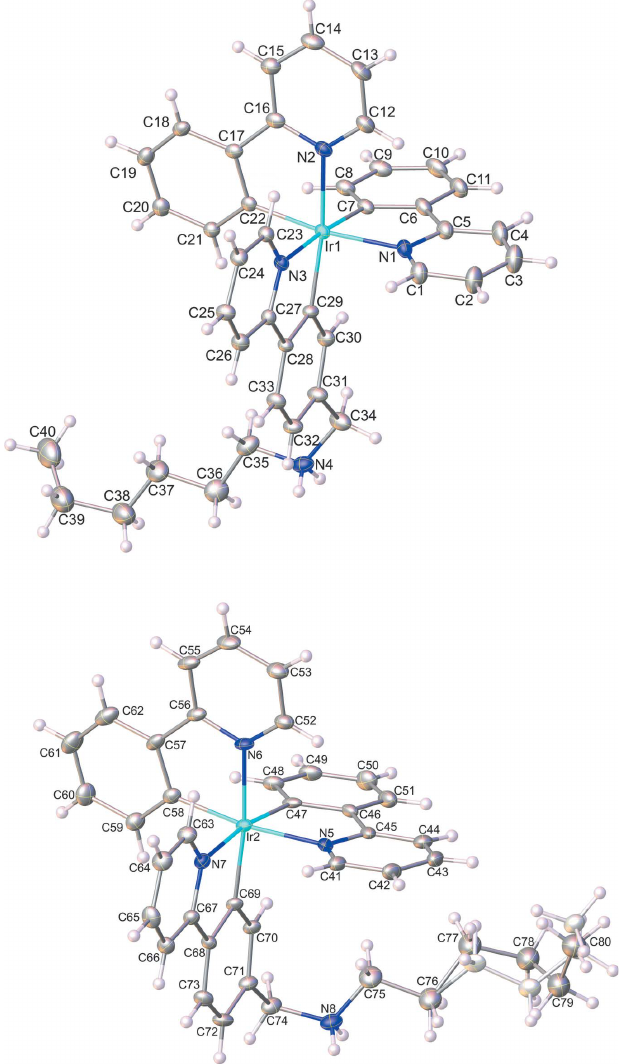
Figure 1 A view of the molecular structures of the two independent cationic molecules of the title compound, with the atom labelling. Displacement ellipsoids are drawn at the 35% probability